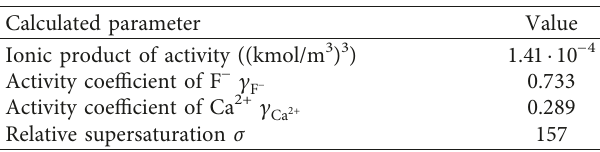
Figure 4: Experimental setup.1, feed tank with a stirrer; 2, metering pump; 3, static mixer/pipe; 4, storage tank; 5, control valve; 6, sampling nozzle; 7, thermostat. Equipment instrumentation and automatics: flow rate automatic adjustment with registration (FCR) and temperature measurement with the identification of a setpoint value and registration (TIR). Table 3: Calculation